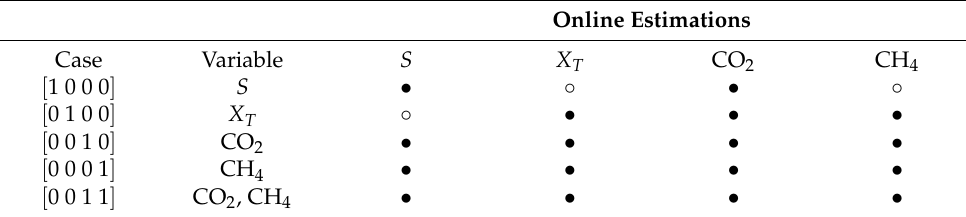
Table 2. Comparative analysis of estimable variables